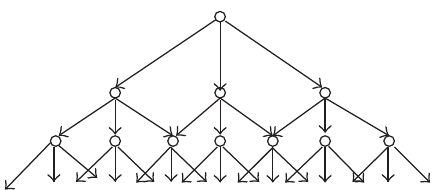
Figure 2: Triangulation of the Riemann surface 𝑆 1,1 . Figure 3: The Bratteli diagram of Markov’s cluster 𝐶 ∗